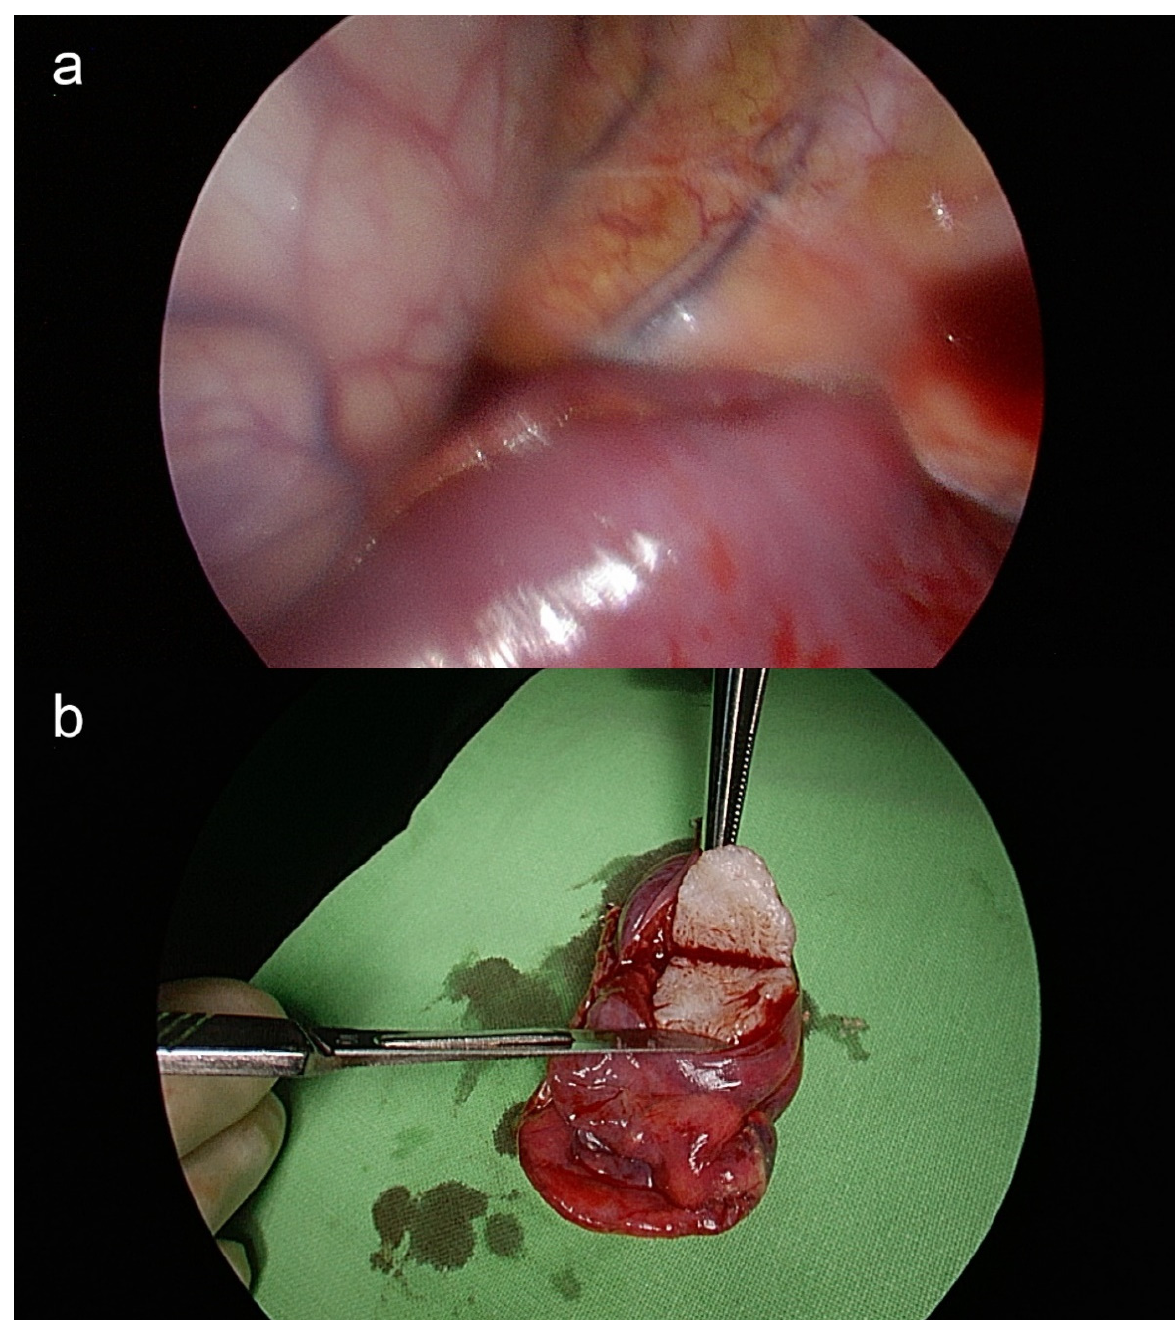
Figure 2. Intraoperative photography. The ( a ) tumor in the right lower lobe of lung showed ( b ) whitish firm solid tumor measuring 1.5 × 1.5 × 1.5 cm 3 in size.